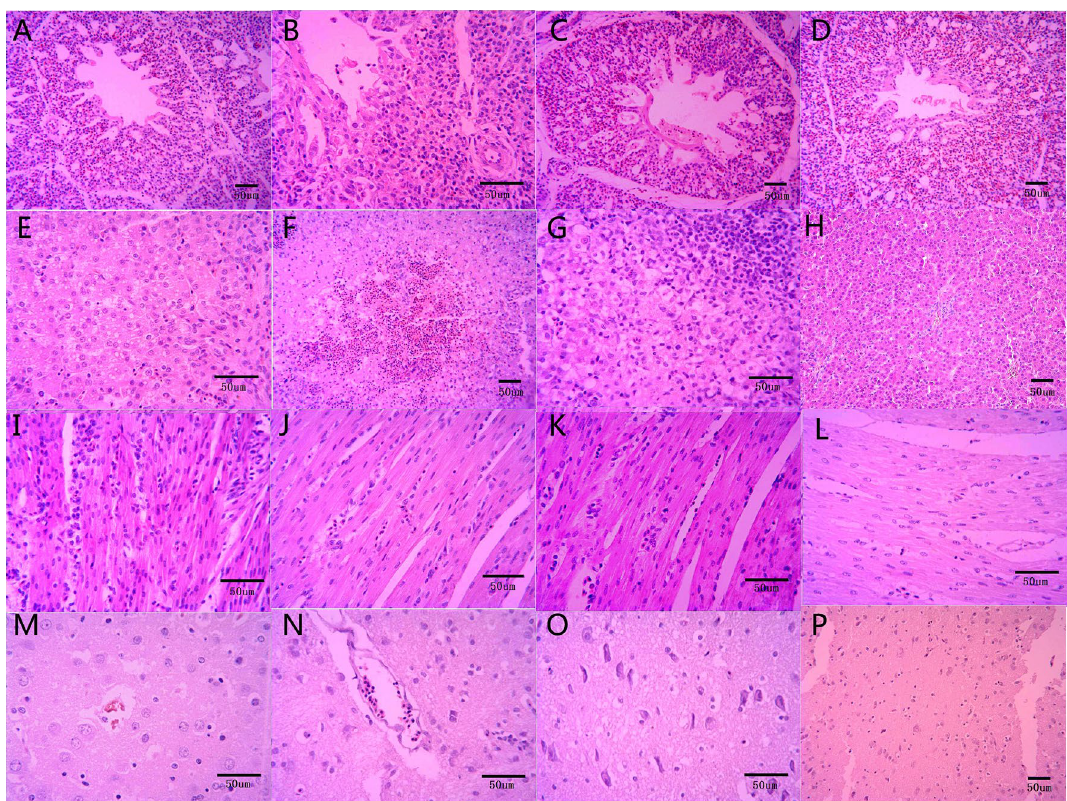
Figure 4. Microscopic pathological changes in lung, liver, heart and brain of chickens infected with NDRV by the s.c. route. ( A ) Lung, 3 dpi: mild interstitial pneumonia with inflammatory cell infiltration and haemorrhage; ( B ) Lung, 6 dpi: Moderate interstitial pneumonia; ( C ) Lung, 9 dpi: Mild congestion and lymphocyte infiltration; ( D ) Lung, the control group: the detection of erythrocytes in parabronchi and air capillaries; ( E ) Liver, 3 dpi: severe hepatocyte steatosis and necrosis ( F ) Liver, 6 dpi: severe hepatocyte degeneration, necrosis, inflammatory cell infiltration and focal bleeding; ( G ) Liver, 9 dpi: mild inflammatory cell infiltration; ( H ) Liver, the control group: no obvious lesions; ( I ) Heart, 3 dpi: moderate inflammation and granularity of the cytoplasm in cardiomyocytes; ( J ) Heart, 6 dpi: mild inflammatory cell infiltration; ( K ) Heart, 9 dpi: mild inflammatory cell infiltration; ( L ) Heart, the control group: no microscopic lesions; ( M ) Brain, 3 dpi: no obvious microscopic lesions; ( N ) Brain, 6 dpi: no obvious microscopic lesions; ( O ) Brain, 9 dpi: no obvious microscopic lesions; ( P ) Brain, the control group: no obvious microscopic